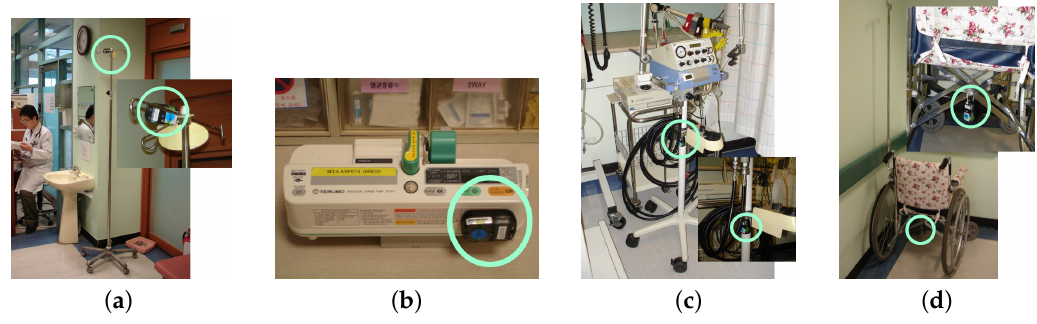
Figure 1. Mobile medical assets with mobile nodes. ( a ) IV Pole; ( b ) Syringe Pump; ( c ) Ventilator; ( d ) Wheel Chair [17]. (With the permission of IEEE